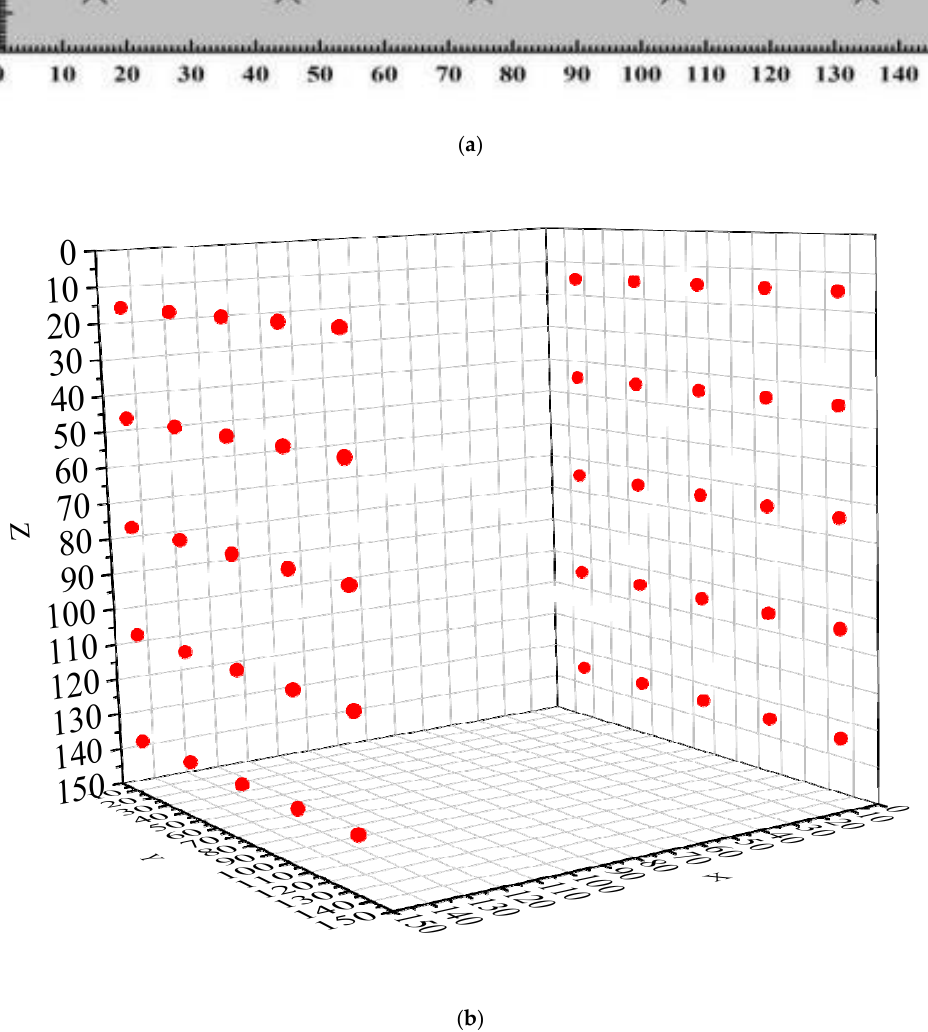
Figure 5. The layout of measuring points. ( a ) two-dimensional; ( b )